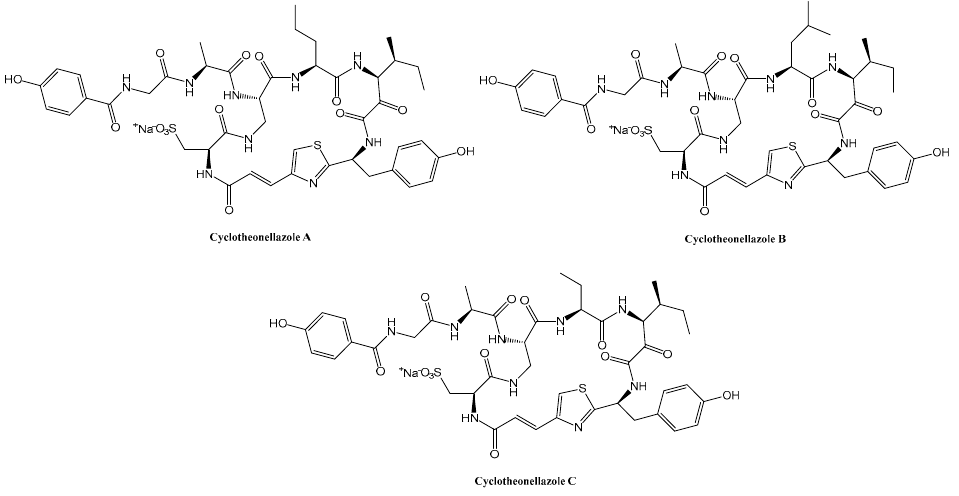
Figure 14. Structures of Cyclotheonellazoles A–C.